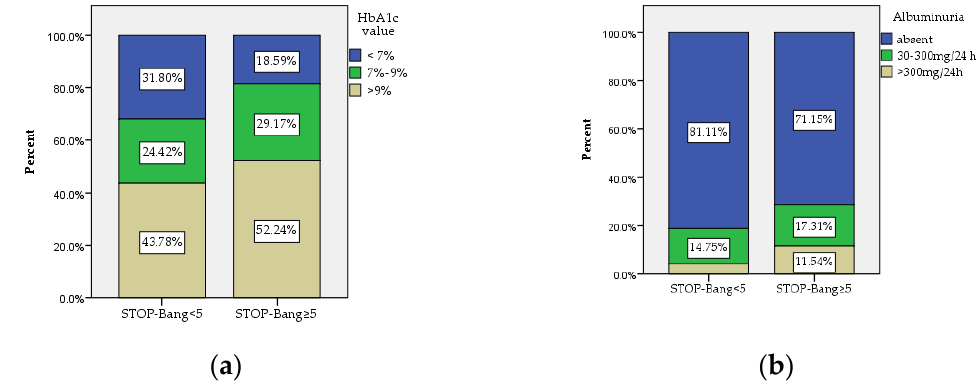
Figure 3. The distribution within the two study groups of ( a ) HbA1c: patients with STOP ‐ Bang scores ≥ 5 had in a significantly higher percentage HbA1c > 7% ( p = 0.002); ( b ) albuminuria: patients with STOP ‐ Bang scores ≥ 5 presented in a significantly higher percentage albuminuria ( p = 0.005). HbA1c: glycated hemoglobin.